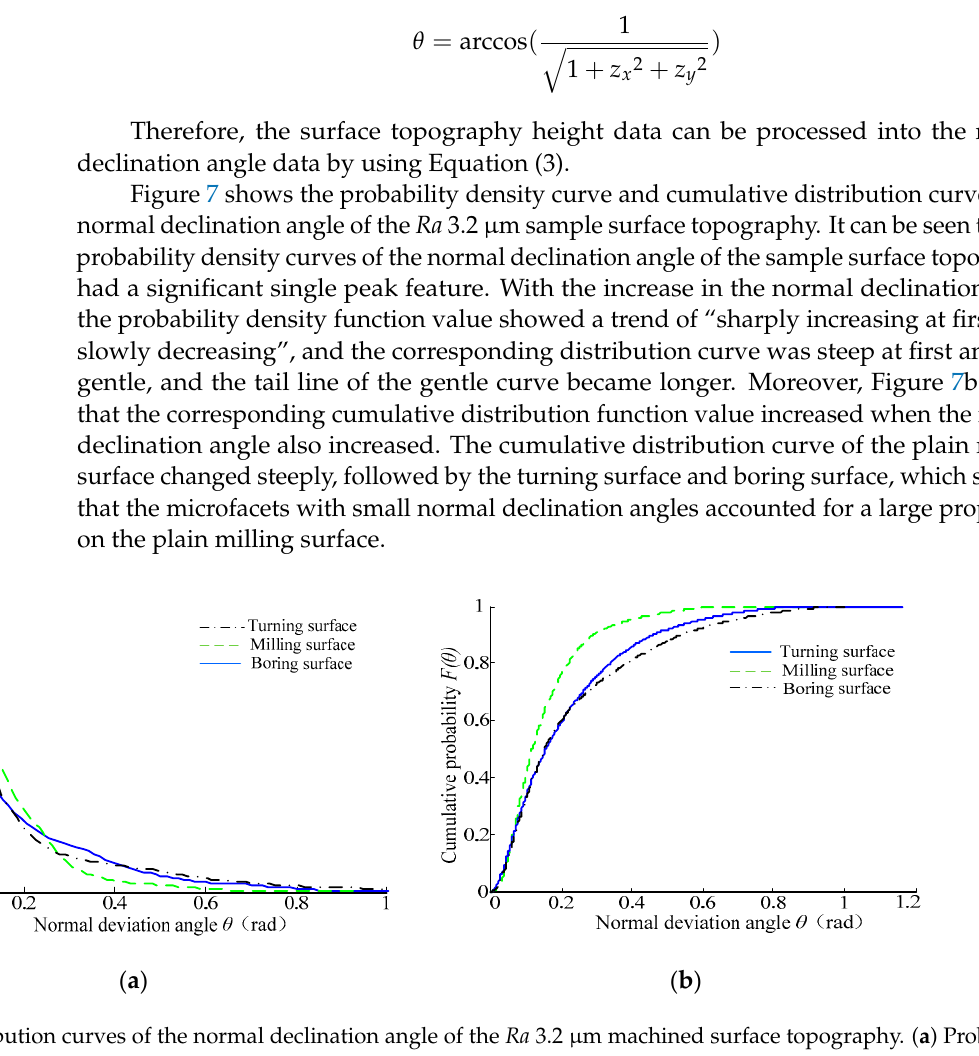
Figure 6. Measurement results of the sample surface topography: ( a ) Ra 3.2 turning; ( b ) Ra 3.2 plain milling; ( c ) Ra 3.2 boring; ( d ) Ra 0.8 turning; ( e ) Ra 0.8 plain milling; ( f ) Ra 3.2 boring.